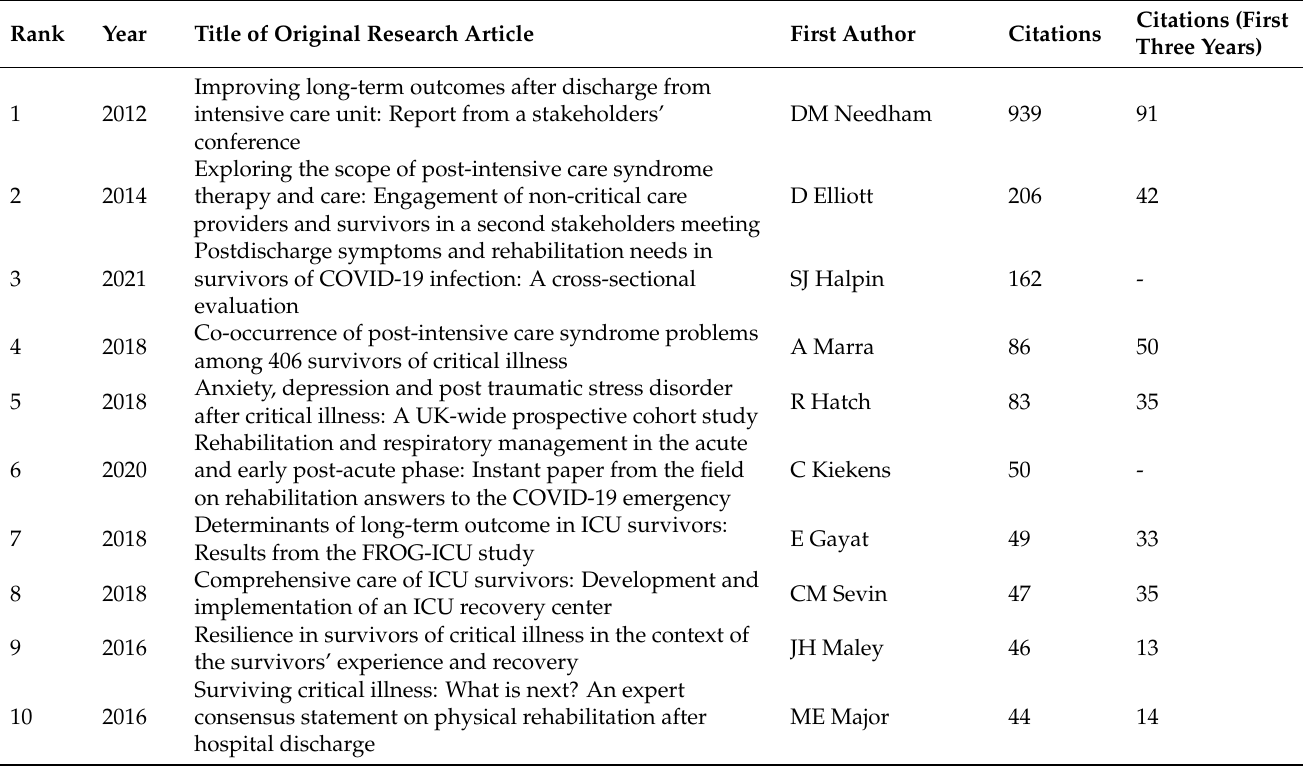
Table 5. Most-cited original research articles on post-intensive care syndrome, ordered by citations.